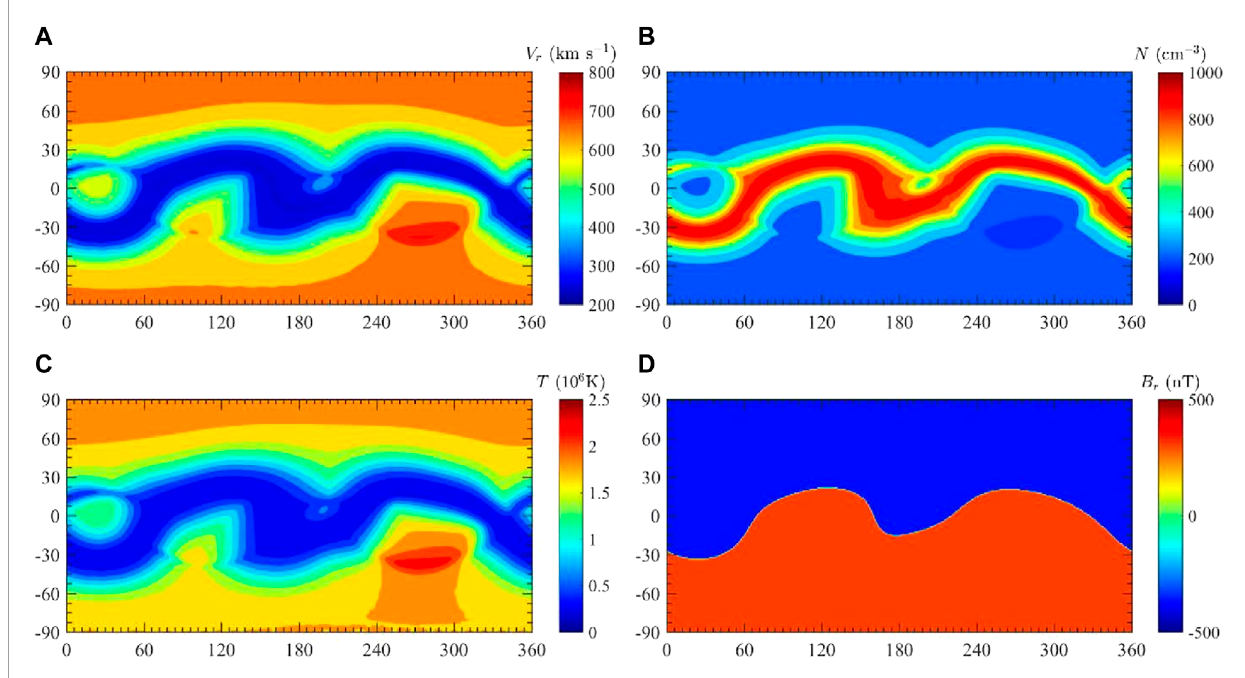
FIGURE 2 Maps of solar wind parameters at the lower boundary of 0.1 au for CR 2053. (A–D) The panels show the radial velocity Vr (km/s), number density N ( cm −3 ) , temperature T (K), and radial magnetic field Br (nT) (Shen et al.,